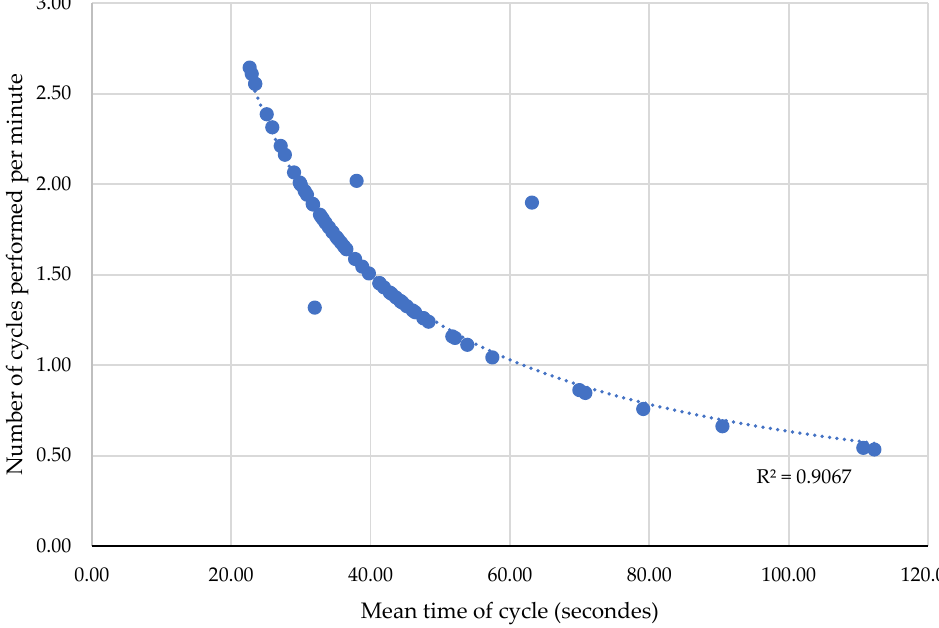
Figure 7. Dependence of the number of cycle doors per minute on the mean time of the cycle.